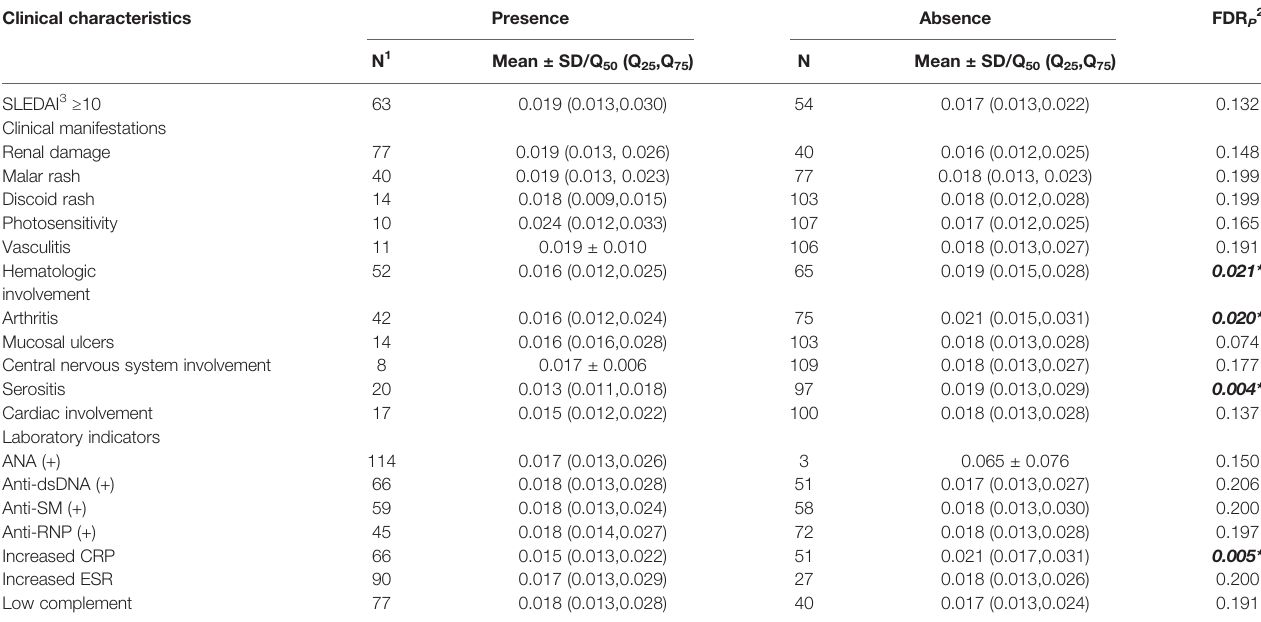
TABLE 3 | Association between ZFP90 mRNA expression levels and SLE clinical characteristics in cases. Clinical